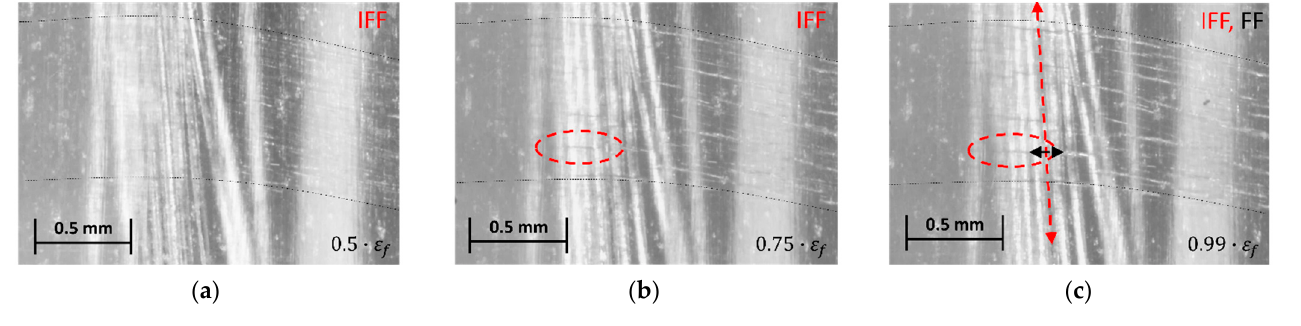
Figure 17. Representative micrograph sequence (reflected light in situ microscopy of the specimen surface), illustrating the occurrence of transverse inter-fiber cracking (IFF) and fiber-fracture (FF) in the AlFGFRP material under static loading. The images refer to 50% ( a ), 75% ( b ) and 99% ( c ) of the strain to